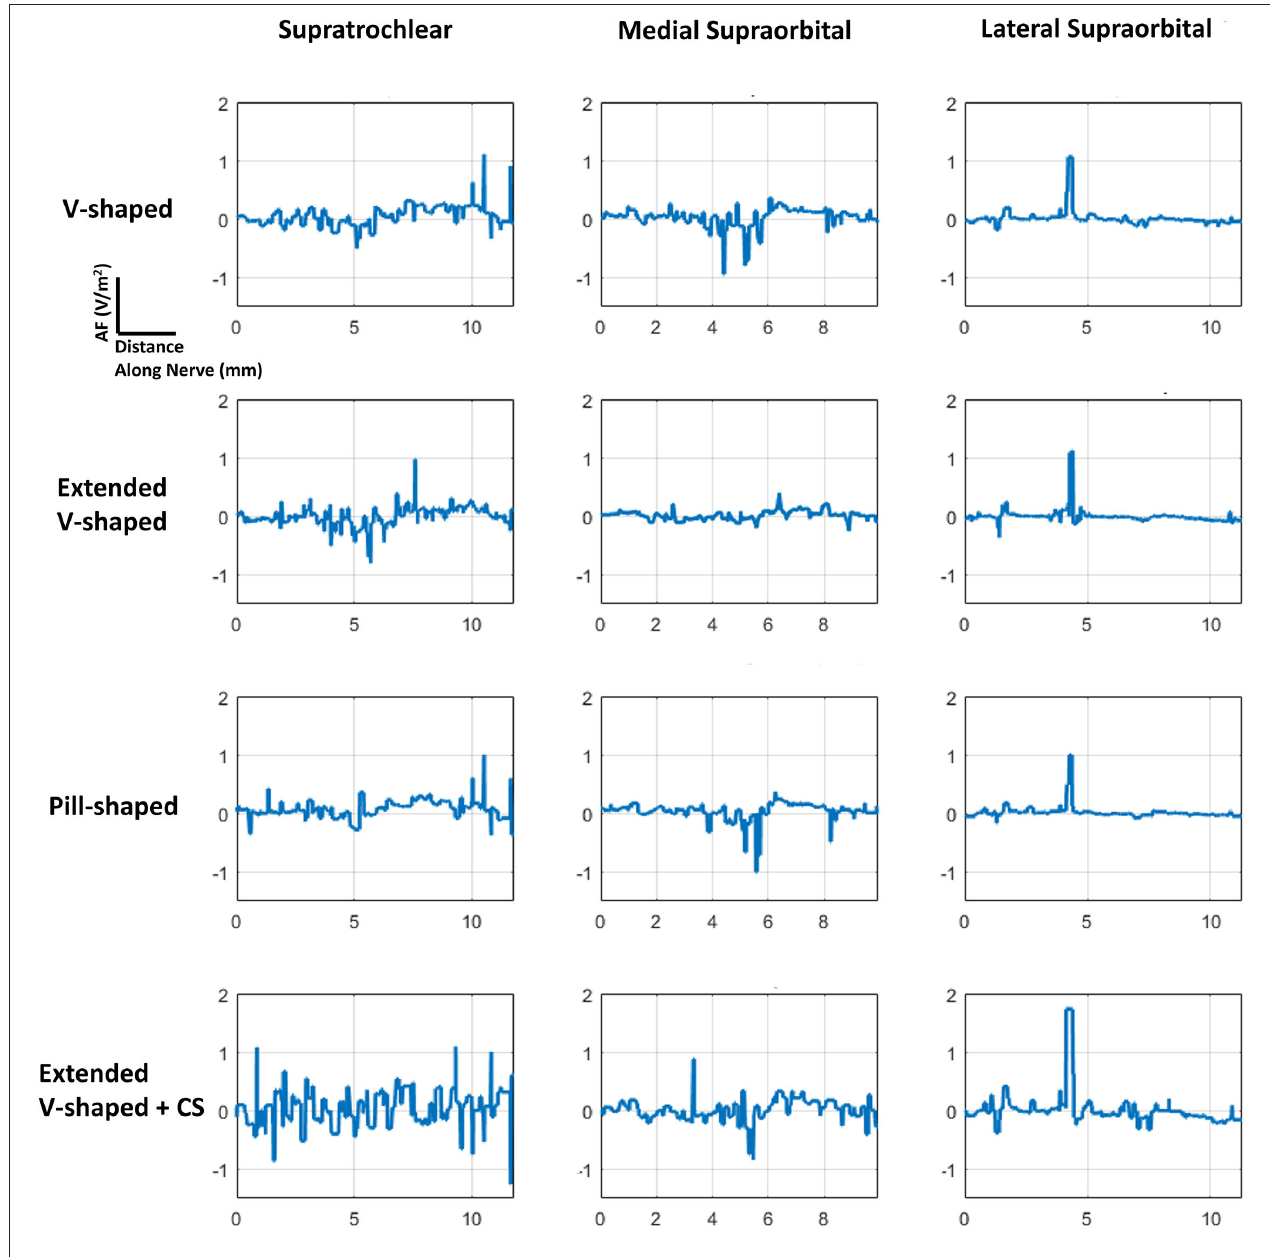
FIGURE 5 | AF plots for each of the configurations simulated. Since each nerve had a dominant orientation (inferior to superior), plots were generated along a single dimension. Further, a straight section of the nerve located approximately at the middle of the electrode was considered for each of the individual nerves. The same section was used when comparing across the montages. The plots were also normalized with respect to the induced values due to the V-shaped design to facilitate easier comparison.